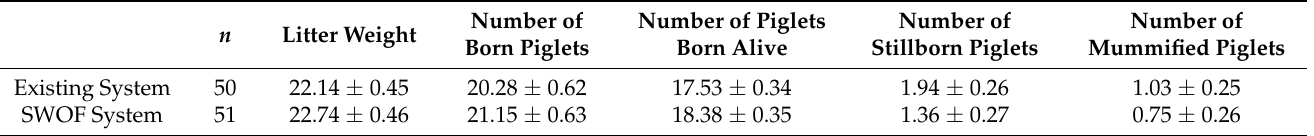
Table 8. Sows’ litter performance characteristics (LSM ± SE; except for litter weight in kg, mean ± SD) in the existing and SWOF